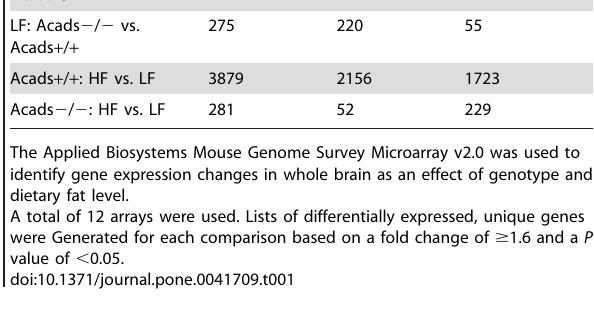
Experimental comparison